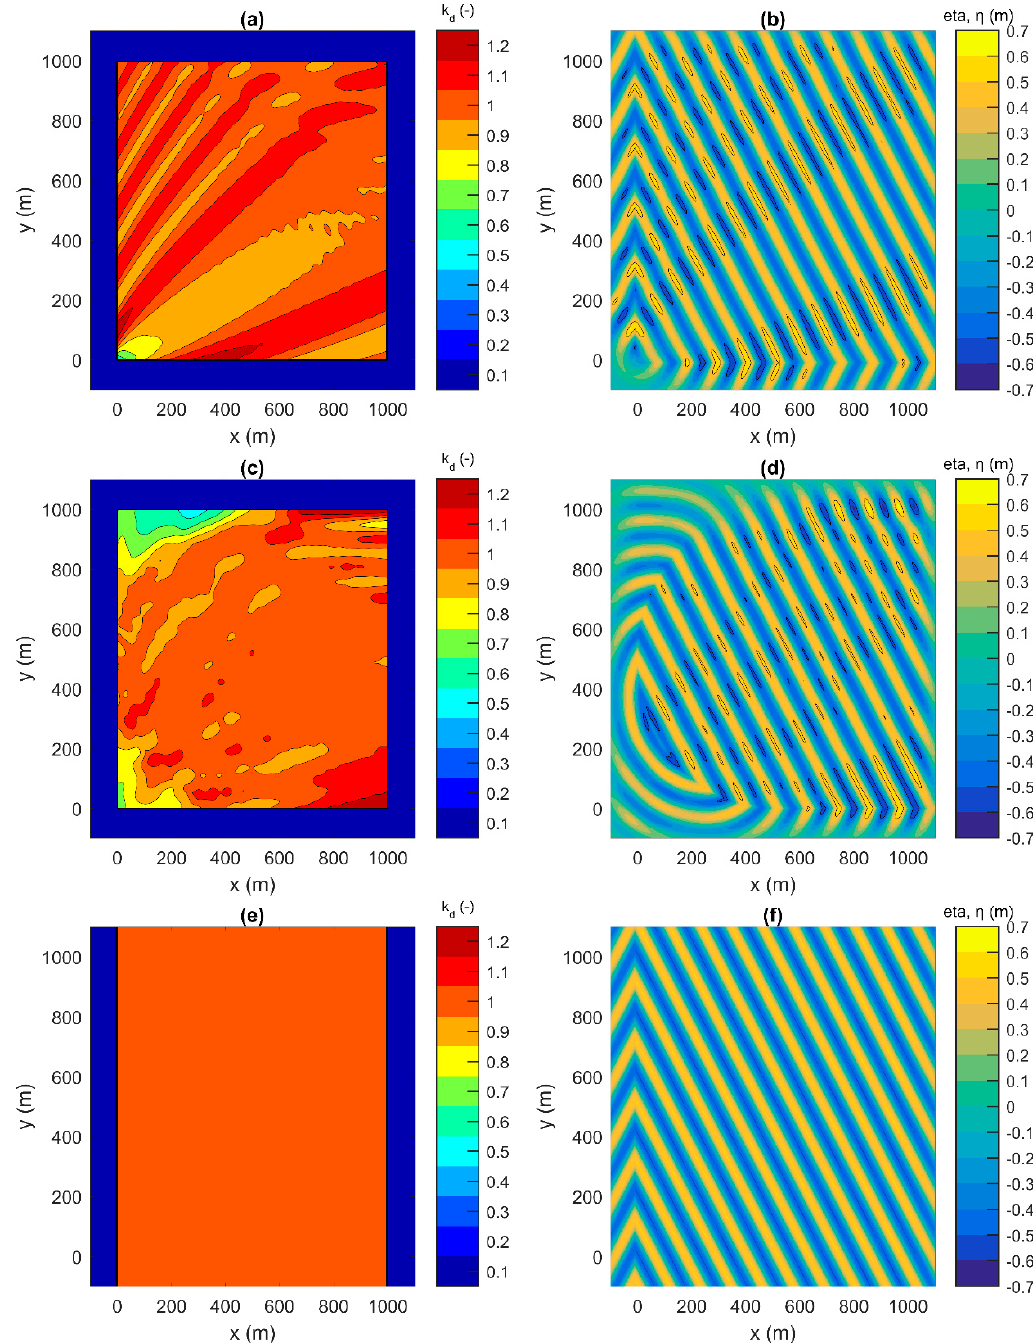
Figure 5. Disturbance coefficient, k d , and water surface elevation, η , in the inner computational domain at t = 80 T for regular incident waves with H = 1 m, T = 12 s, and θ = 30 ◦ generated by an L-shaped wave generation layout ( a , b ), an arc-shaped wave generation layout ( c , d ), and by the use of periodic boundaries ( e , f ).